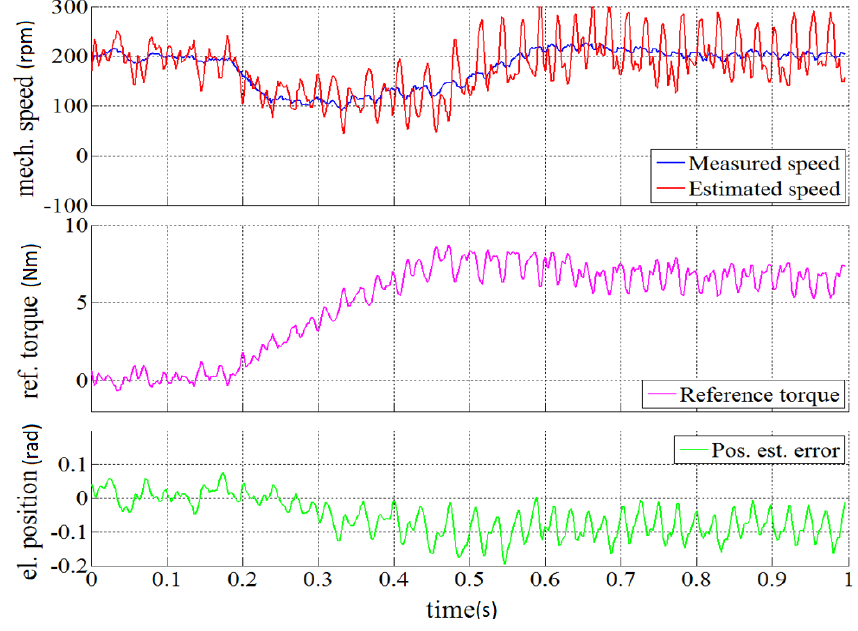
Figure 19. Motor #1: Increased bandwidth sensorless speed control (MTPA), load disturbance at 200 rpm, 0 to 6 Nm load, gain adaptation and i i 1 regulation (150 mA).